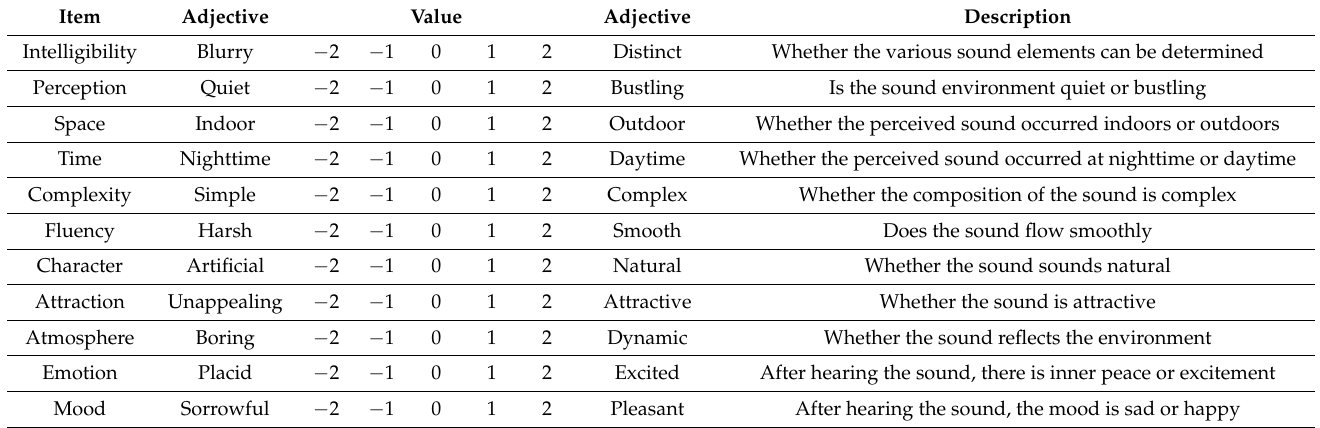
Table 2. Contents of the